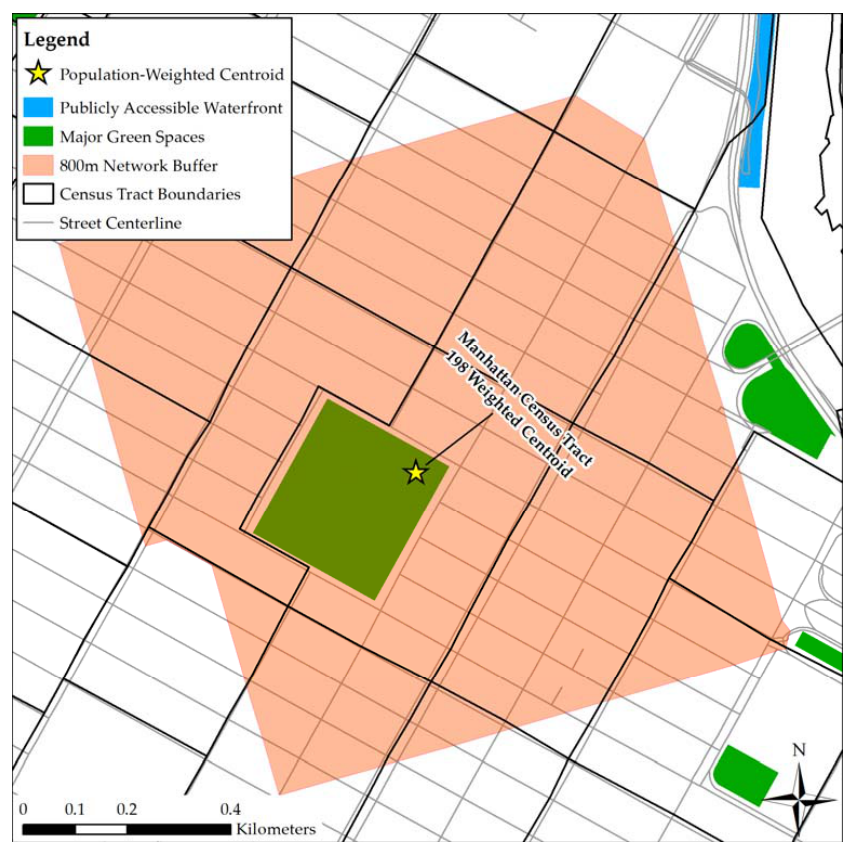
Figure 3. Example measures of access to major green spaces and waterfront areas.